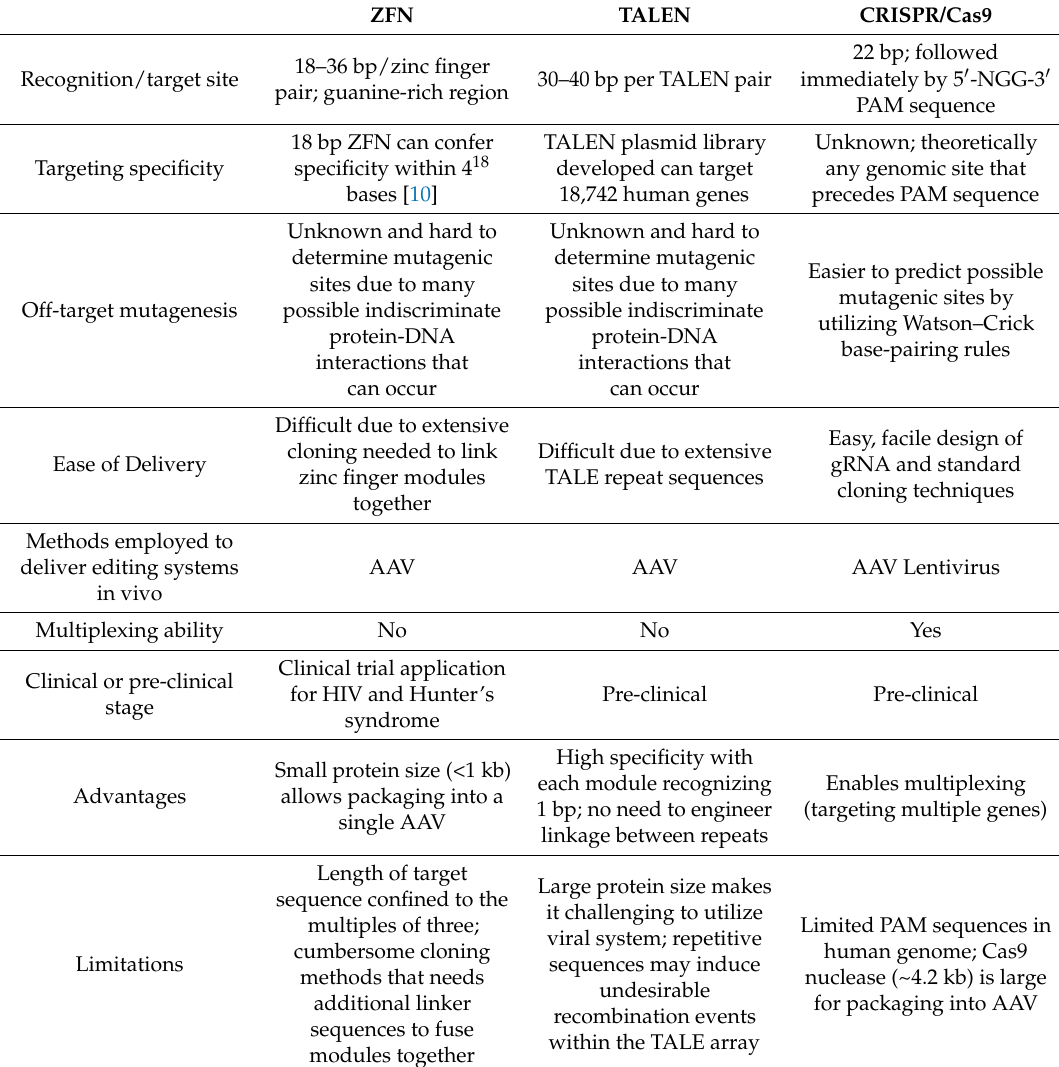
Table 2. Applications of the technology in ZFN, TALEN, and CRISPR/Cas9 gene